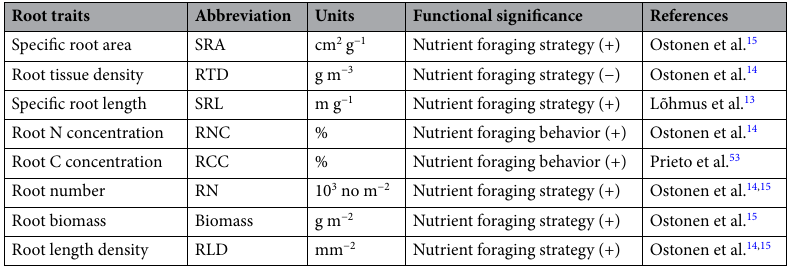
Table 1. List of root traits measured and their demonstrated foraging mechanisms of roots. Symbols (+) and (−) indicate positive and negative relationships between traits and functions,